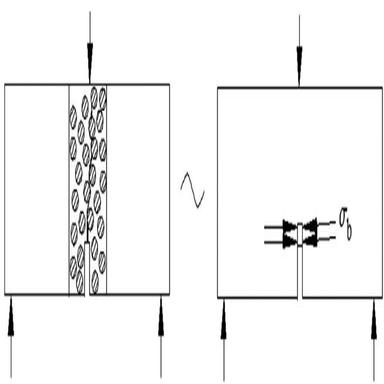
Representation of the bridging mechanism in a concrete beam adapted from . Note: σb represents the bridging stress.